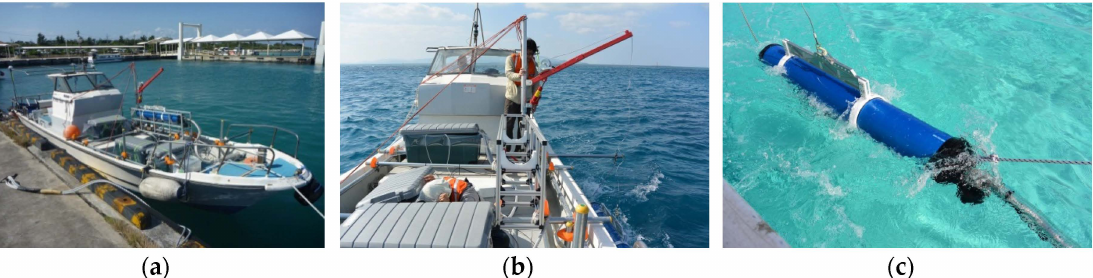
Figure 5. Photographs of coral observation by the fluorescence imaging LIDAR system at Taketomi Island, Okinawa Japan. ( a ) Standby condition for cruising to the observation point; ( b ) The boat during the coral observation; ( c ) The towable buoy during the coral observation.